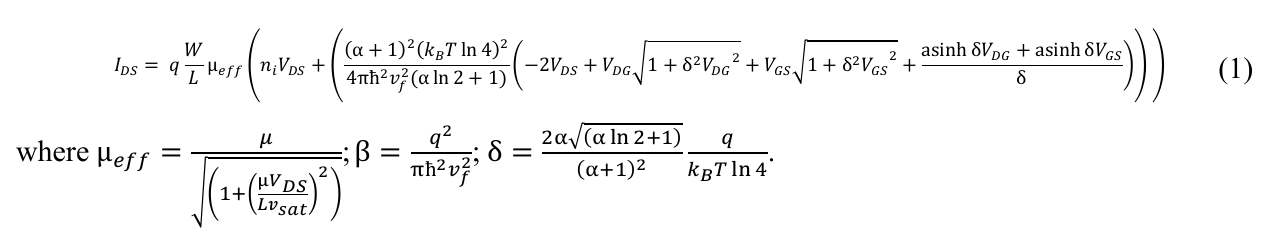
Figure 2. Compact model of GFET (adapted from [17]. Copyright 2013, permission granted by Kristen